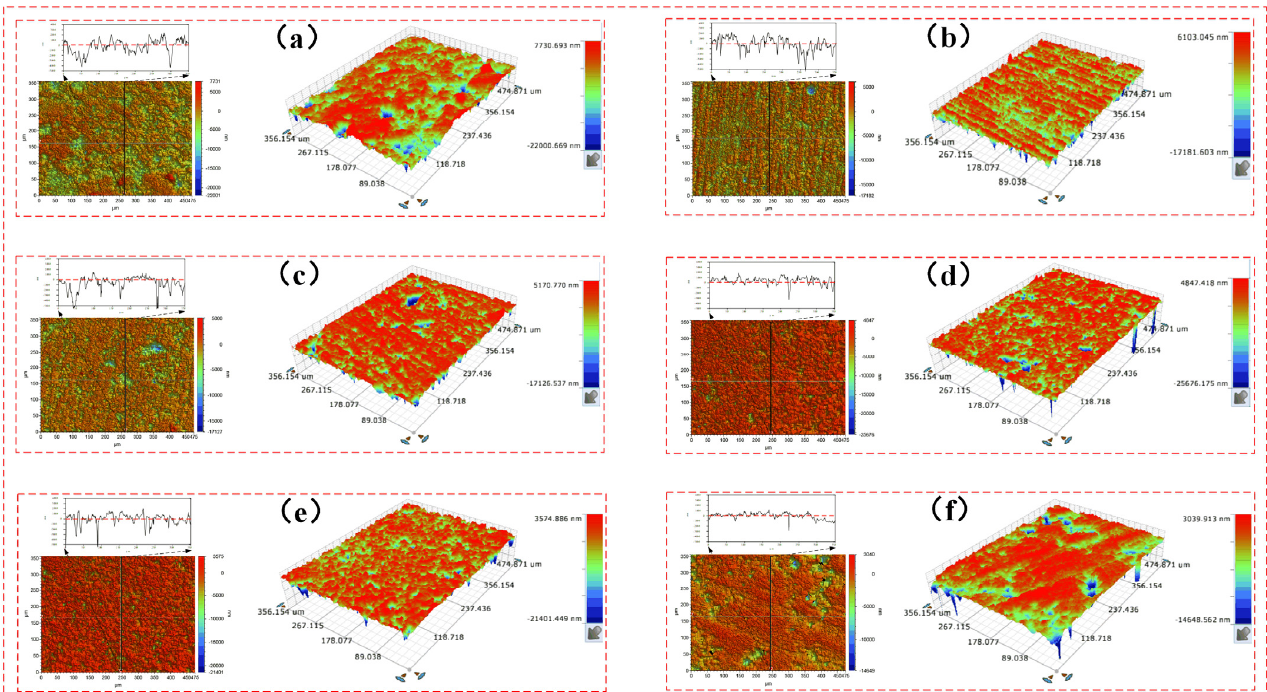
Figure 8. Relationship between surface roughness of the FAP and energy proportion of frequency bands 7 and 8.